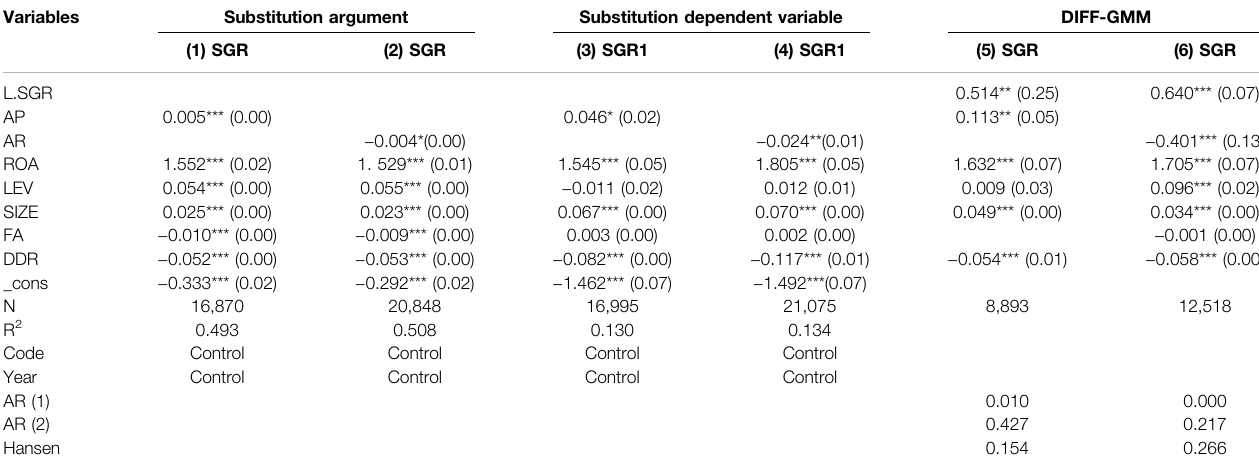
TABLE 9 | Substitution variables and regression methods.